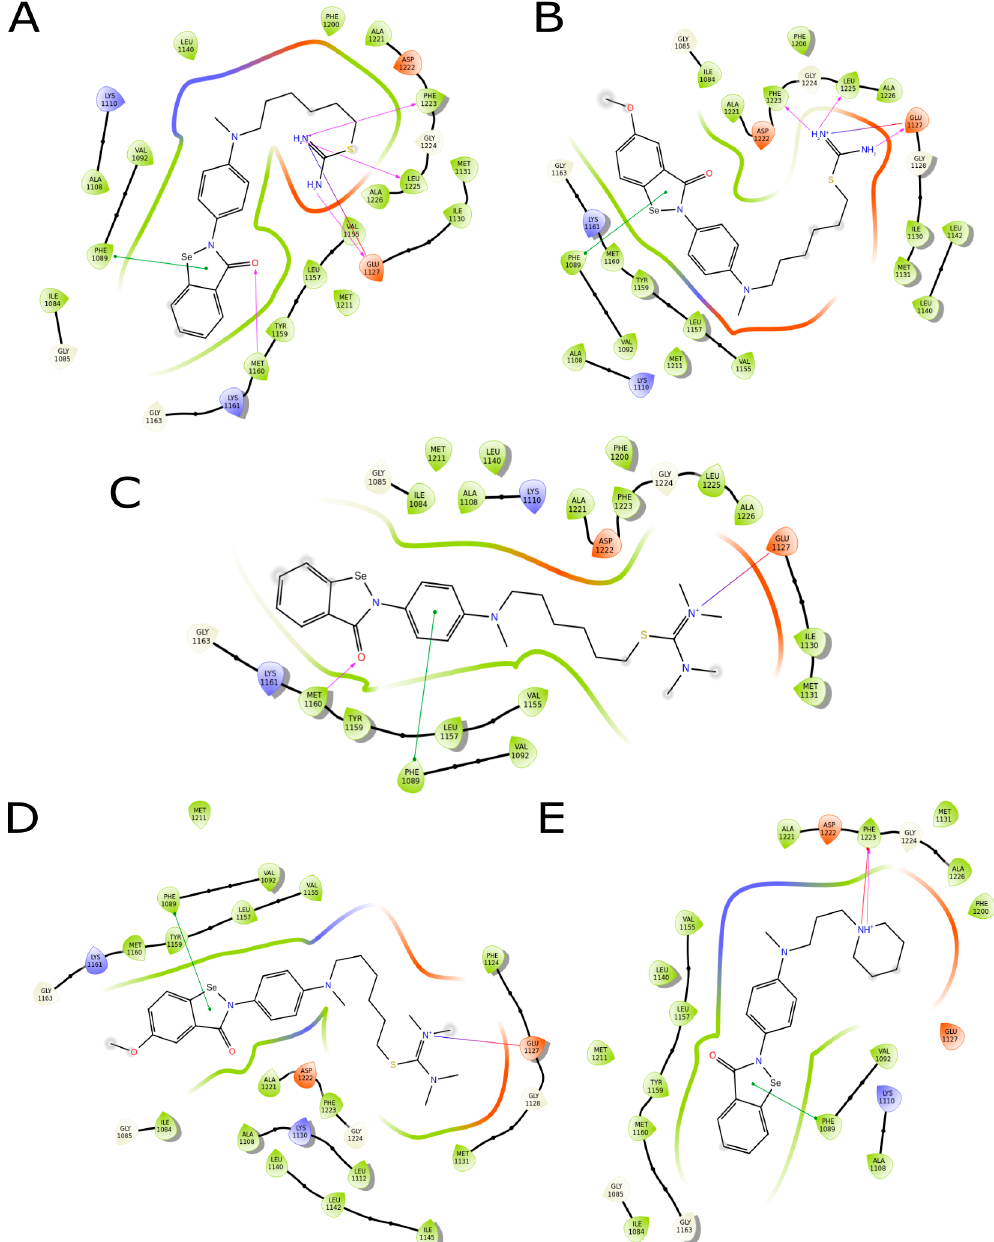
Figure 5. The binding mode of compounds in the ATP binding pocket of c-Met protein in two-dimensional panel. The green full line indicates the π – π stacking interaction, the purple arrow indicates the hydrogen bond and the fuchsia line indicates the ionic bond. The grey shade highlights the solvent exposure region of the small compounds. ( A ) The binding mode of compound 7a . ( B ) The binding mode of compound 7b . ( C ) The binding mode of compound 8a . ( D ) The binding mode of compound 8b . ( E ) The binding mode of compound 12c .